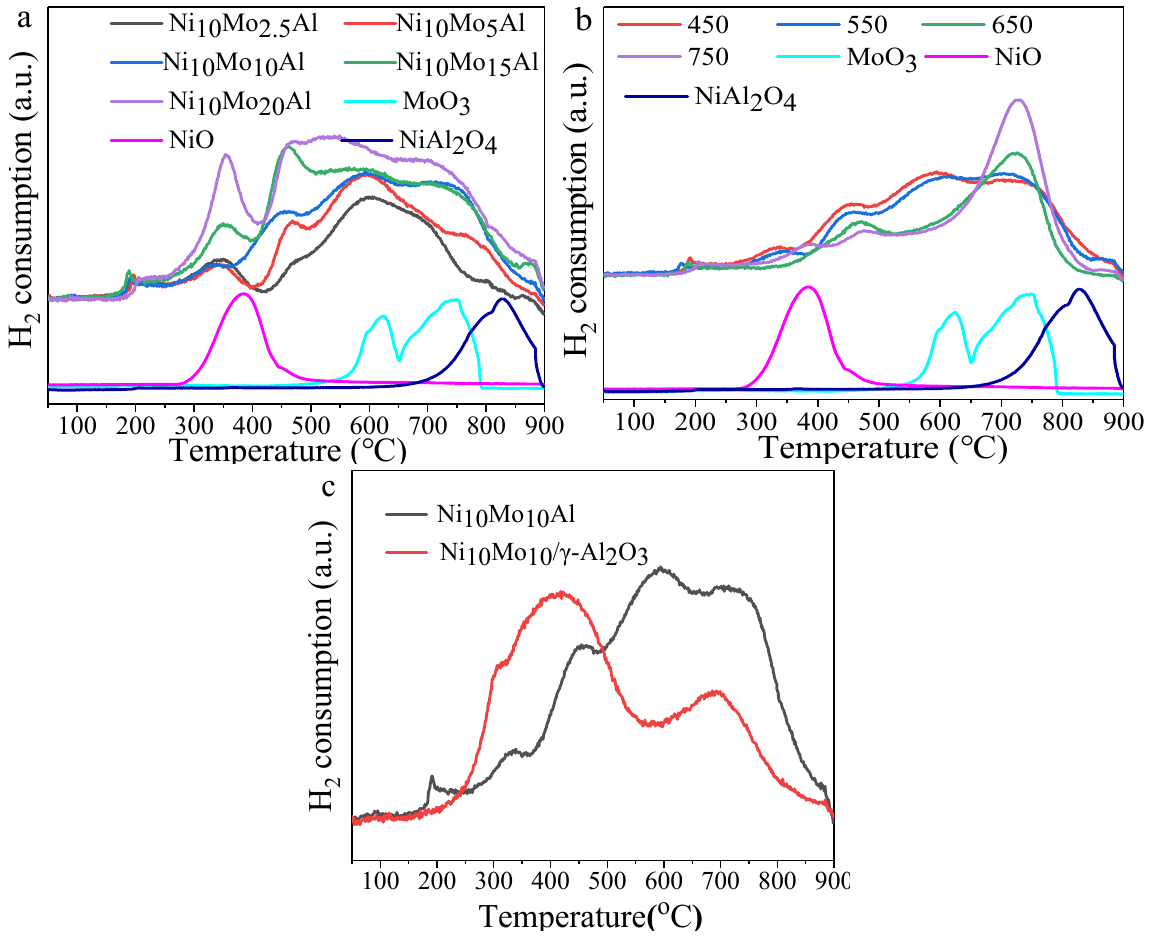
Figure 8. H 2 -TPR profiles of ( a ) Ni 10 Mo x Al, ( b ) Ni 10 Mo 10 Al catalysts calcined at 450–750 °C and ( c ) Ni 10 Mo 10 Al and Ni 10 Mo 10 / γ -Al 2 O 3 catalysts calcined at 450 °C. The H 2 -TPR profiles of Ni 10 Mo 10 Al catalysts calcined at different temperatures are shown in Figure 8b. The H 2 consumption peaks (<600 °C) of reducible NiO and MoO x shifted to higher temperatures with the enhancement of the calcination temperature, indi- cating that the higher calcination temperature promotes the interaction between Ni–Al 2 O 3 and Mo–Al 2 O 3 . In addition, the intensity of the reduction peaks (<600 °C) gradually decreased when the calcination temperature was raised from 450 to 750 °C. However, the reduction peak at 750 °C became gradually intense, indicating the formation of NiAl 2 O 4 through the interaction between the Ni species and Al 2 O 3 at a high calcination temperature, which is in agreement with the XRD and UV-vis characterization results.